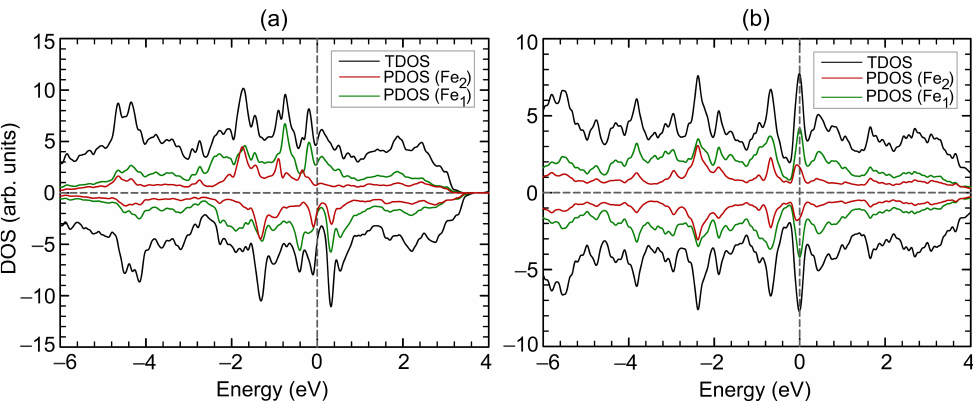
Figure 5. Total (TDOS) and partial (PDOS) densities of states for Fe 3 Se 4 under 7% ( a ) and 14% ( b ) com- pression. Positive and negative values corresponds to spin-up and spin-down channels, respectively. The Fermi level corresponds to zero.